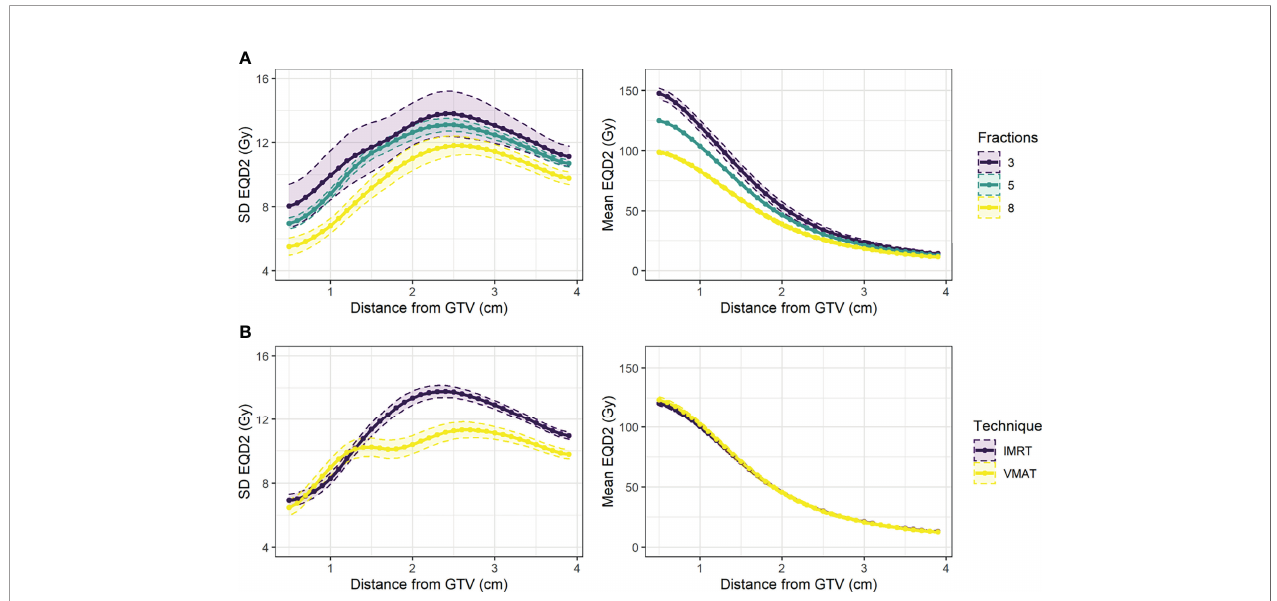
FIGURE 4 | Mean and 95% con fi dence interval across patients for standard deviation of EQD2 (left) and mean EQD2 (right) at distance from the GTV for patients treated (A) on different fractionation regimes (3, 5, or 8 fractions), and (B) using different treatment techniques (IMRT vs.